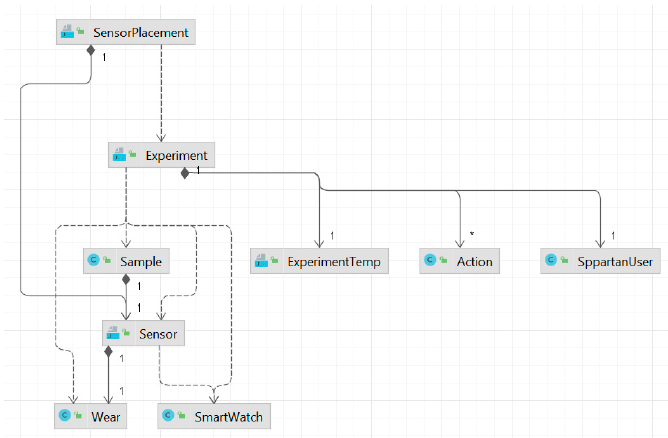
Figure 3. Data model—classes representation of the business model. Number 1 and asterisk indicate cardinality, diamond symbol indicates container.